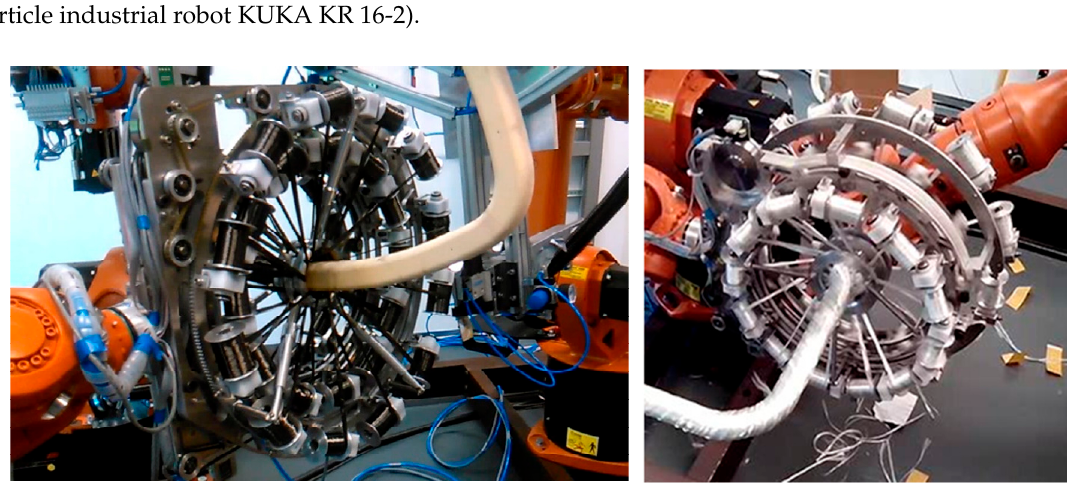
Figure 6. Different views of robot KR 16-2 with non-bearing core frame and fiber-processing head with three guide lines.